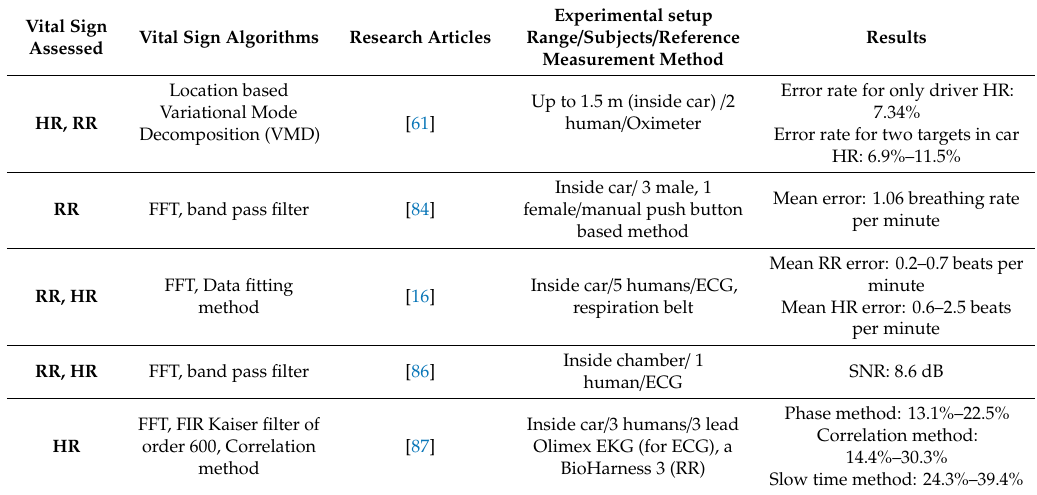
Table 4. Performance comparison of vital sign detection algorithms for in-vehicle